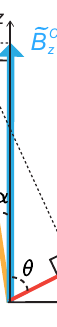
FIG. 15. Illustration of external ac field geometry. Here (cid:5) B C (orange) is the direction of the coil’s ac field in the x - z plane at the location of the sample. Its projection on the NV center axis (cid:5) B C (red) is directly measured. We compute the out-of-plane projec- (blue) and use it as the effective driving tion of the coil field (cid:5) B C z field amplitude to calculate the ac susceptibility χ (cid:7) ac parallel to the c